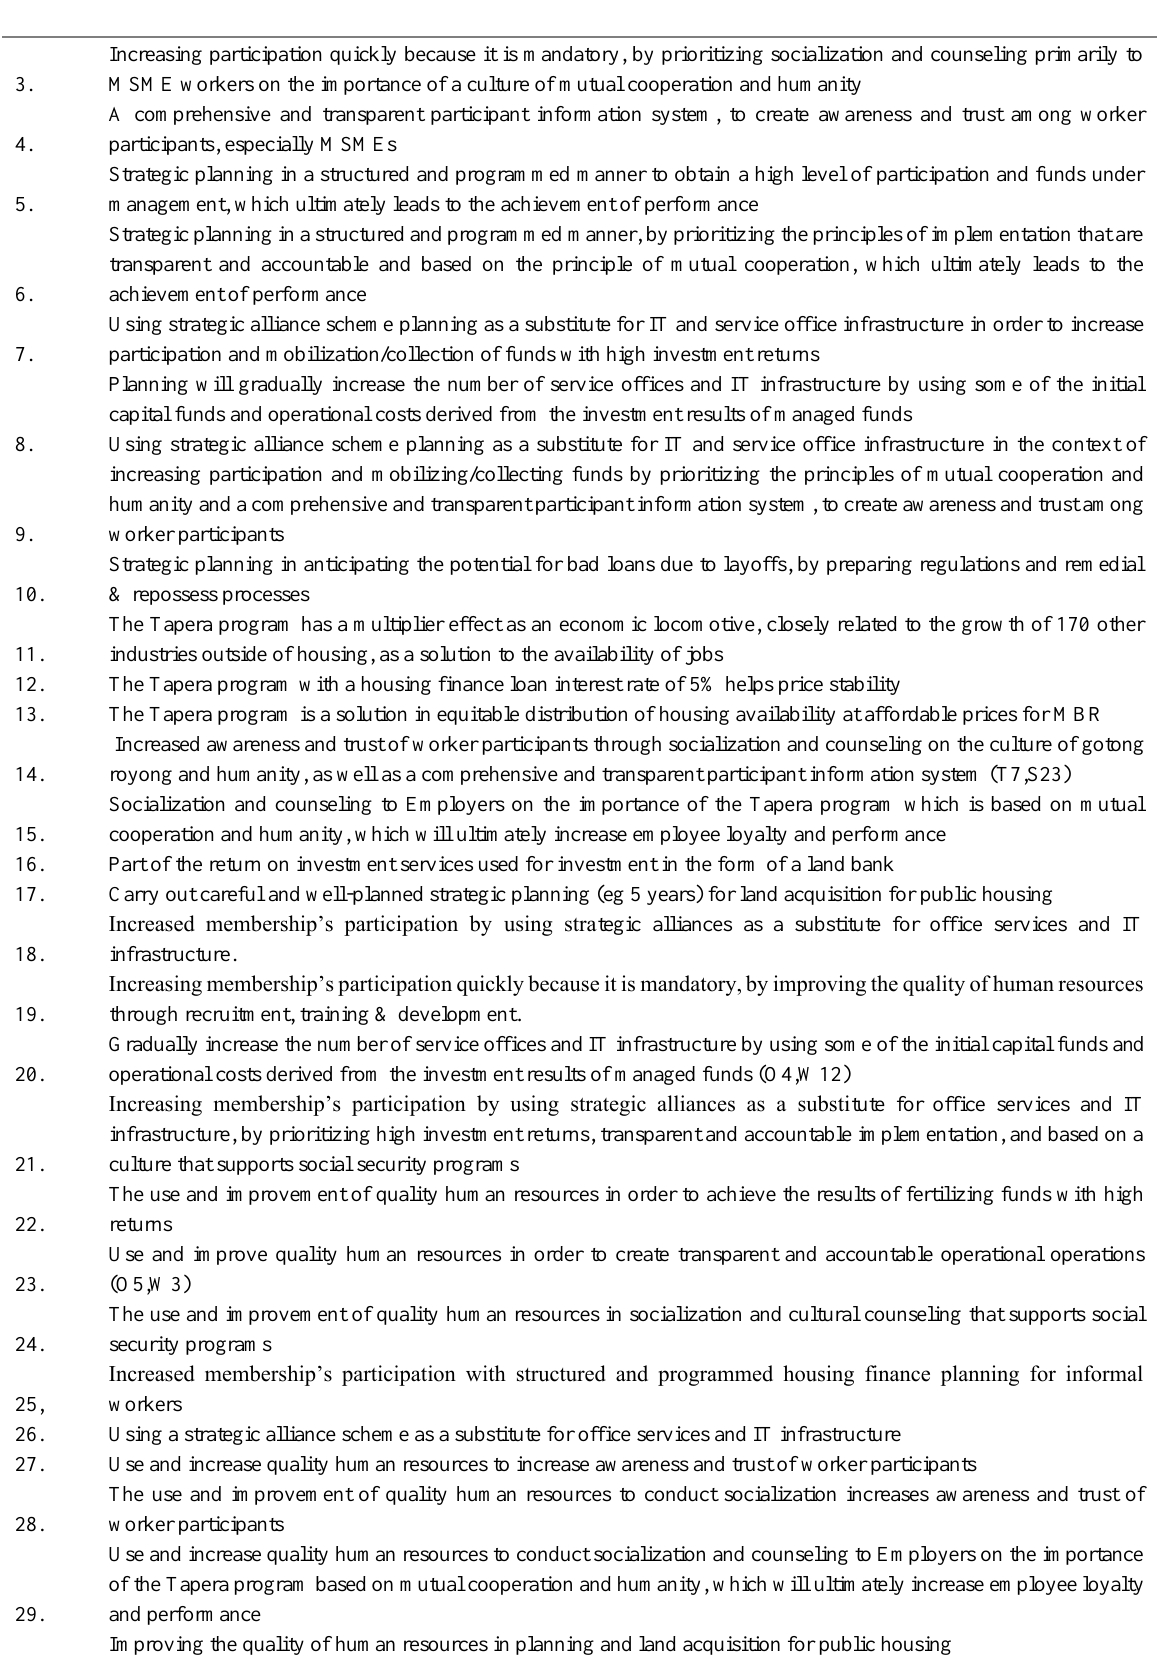
Table 5: Basic Business